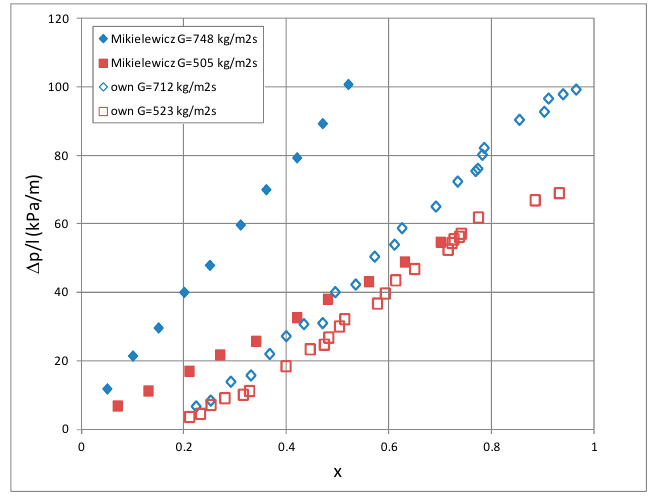
Figure 12. Comparison of own research results with research results of Mikielewicz et al. [9].